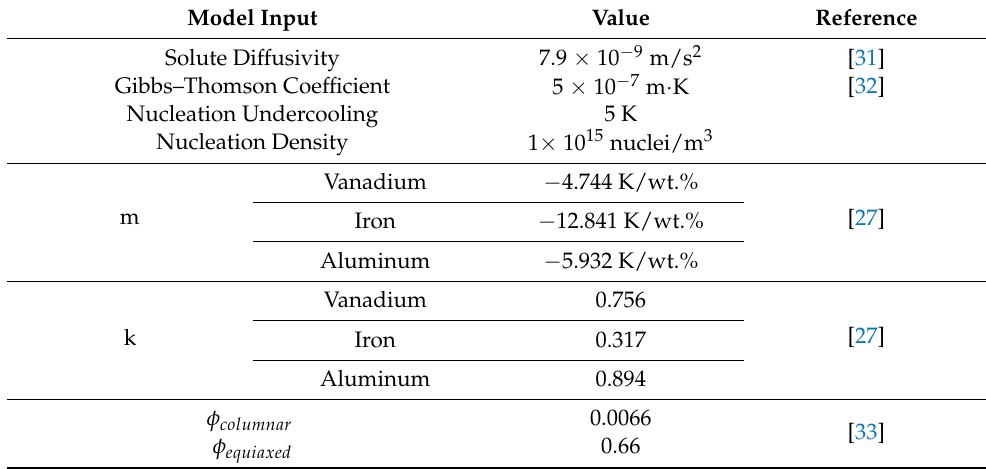
Table 3. Modified KGT model inputs to predict CET in Ti-1023.